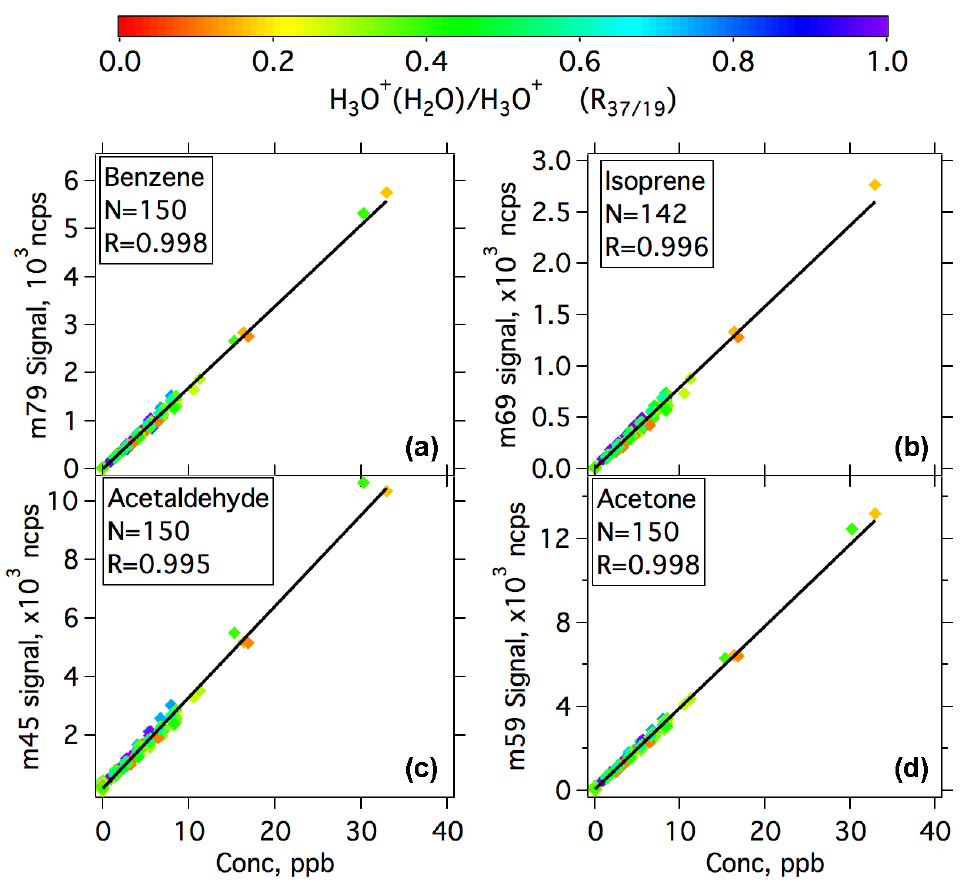
Figure 8. In-flight calibration results of benzene (a) , isoprene (b) , acetaldehyde (c) and acetone (d) during the SONGNEX campaign. Signals for the species have been humidity corrected. Data points are color-coded using R 37 / 19 ratios. The total times ( N ) when gas standard was introduced into the instrument during SONGNEX and correlation coefficients ( R ) are shown in the text box.